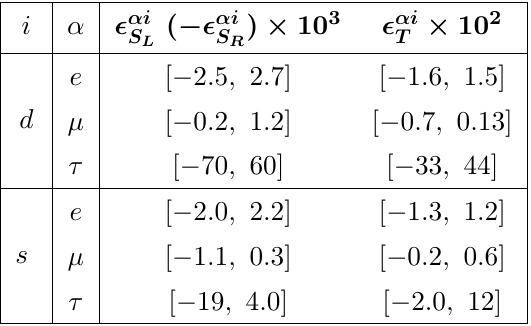
-meson decays for ( s ) are those of − (cid:15) α S R S L